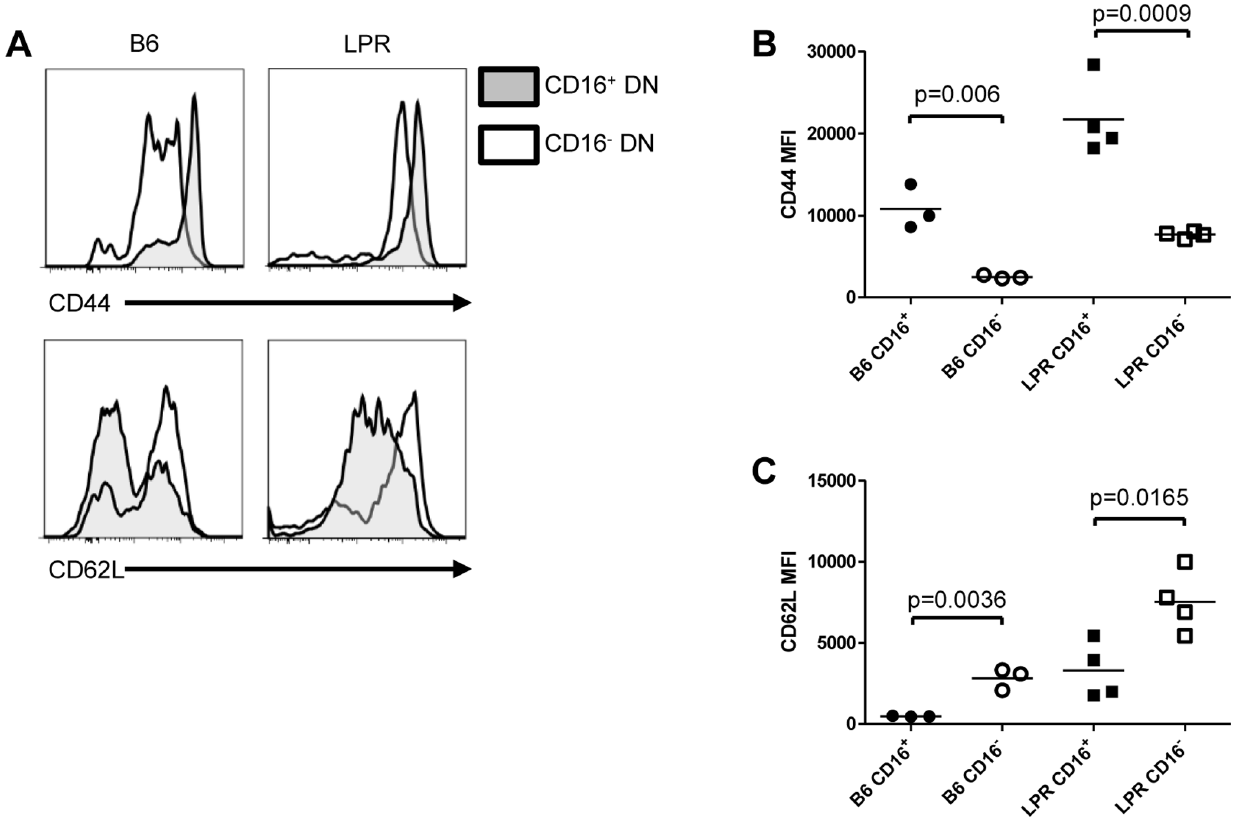
Figure 1. FcR c -expressing DN T cells are a distinct effector-memory subset in both B6 and LPR mice. A. Freshly isolated B6 (n=3, left column) and LPR (n=4, right column) splenocytes were stained for TCR b , CD4, CD8, NK1.1, CD16/32, CD44, and CD62L expression and examined by flow cytometry. Within the DN T cell gate (TCR b + , CD4 2 , CD8 2 , NK1.1 2 ), expression of CD44 (top row) and CD62L (bottom row) in the CD16 + (shaded) and CD16 2 (unshaded) subsets was plotted. B. Median fluorescence intensity (MFI) of CD44 staining in CD16 + and CD16 2 DN T cells for all 7 mice is shown. Unpaired t tests p=0.006 (CD16 + vs. CD16 2 B6 DN T cells) and p=0.0009 (CD16 + vs. CD16 2 LPR DN T cells). C. MFI of CD62L staining in CD16 + and CD16 2 DN T cells for all 7 mice is shown. Unpaired t tests p=0.0036 (CD16 + vs. CD16 2 B6 DN T cells) and p=0.0165 (CD16 + vs. CD16 2 LPR DN T cells).